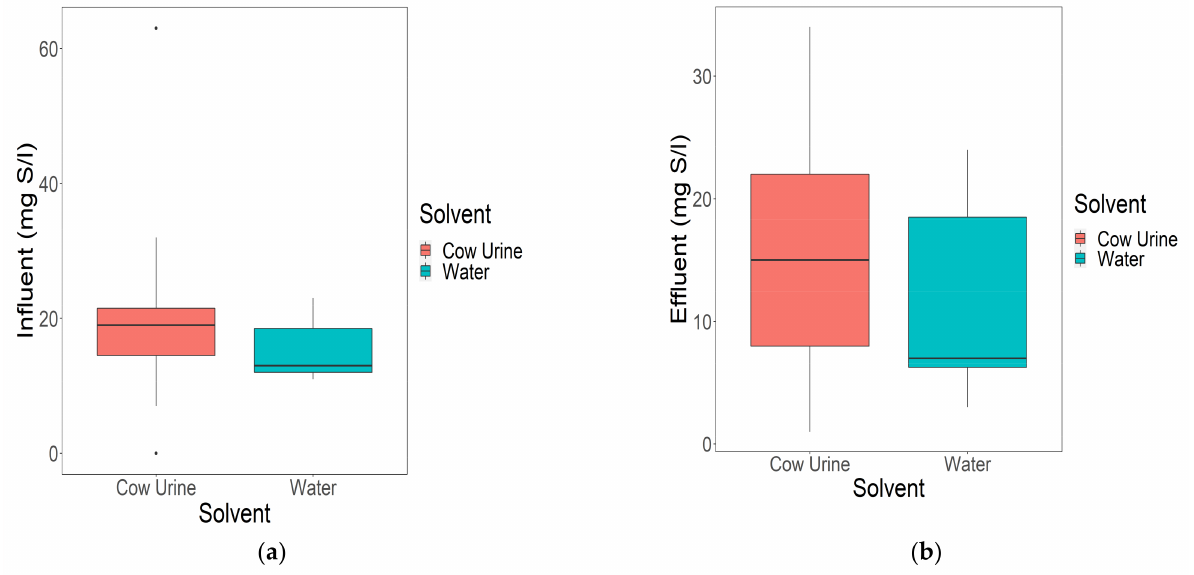
Figure 5. ( a ) Sulphur (S) concentration measured in the influent and ( b ) effluent (mg S/L) of digesters visited in the field study using either cow urine or water as